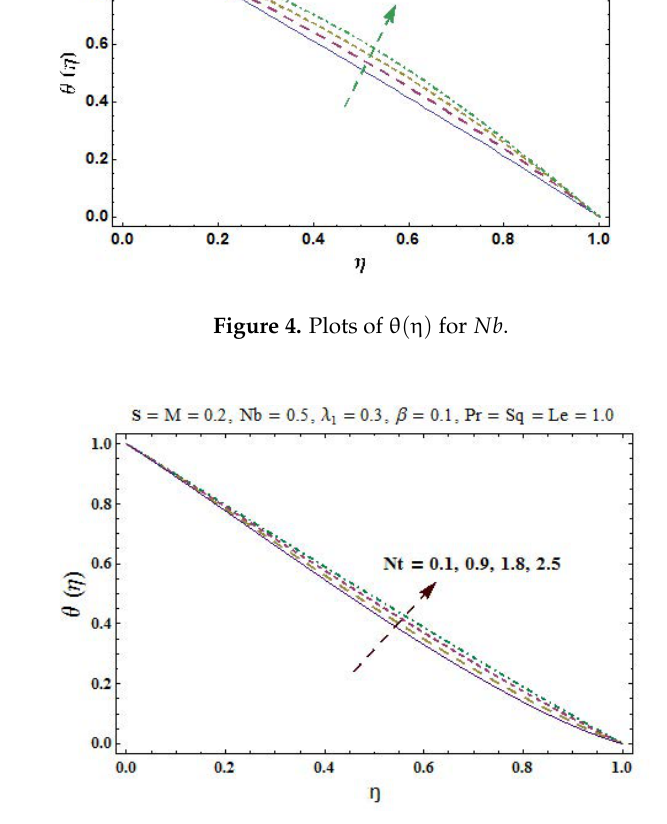
Figure 5. Plots of θ ( η ) for Nt